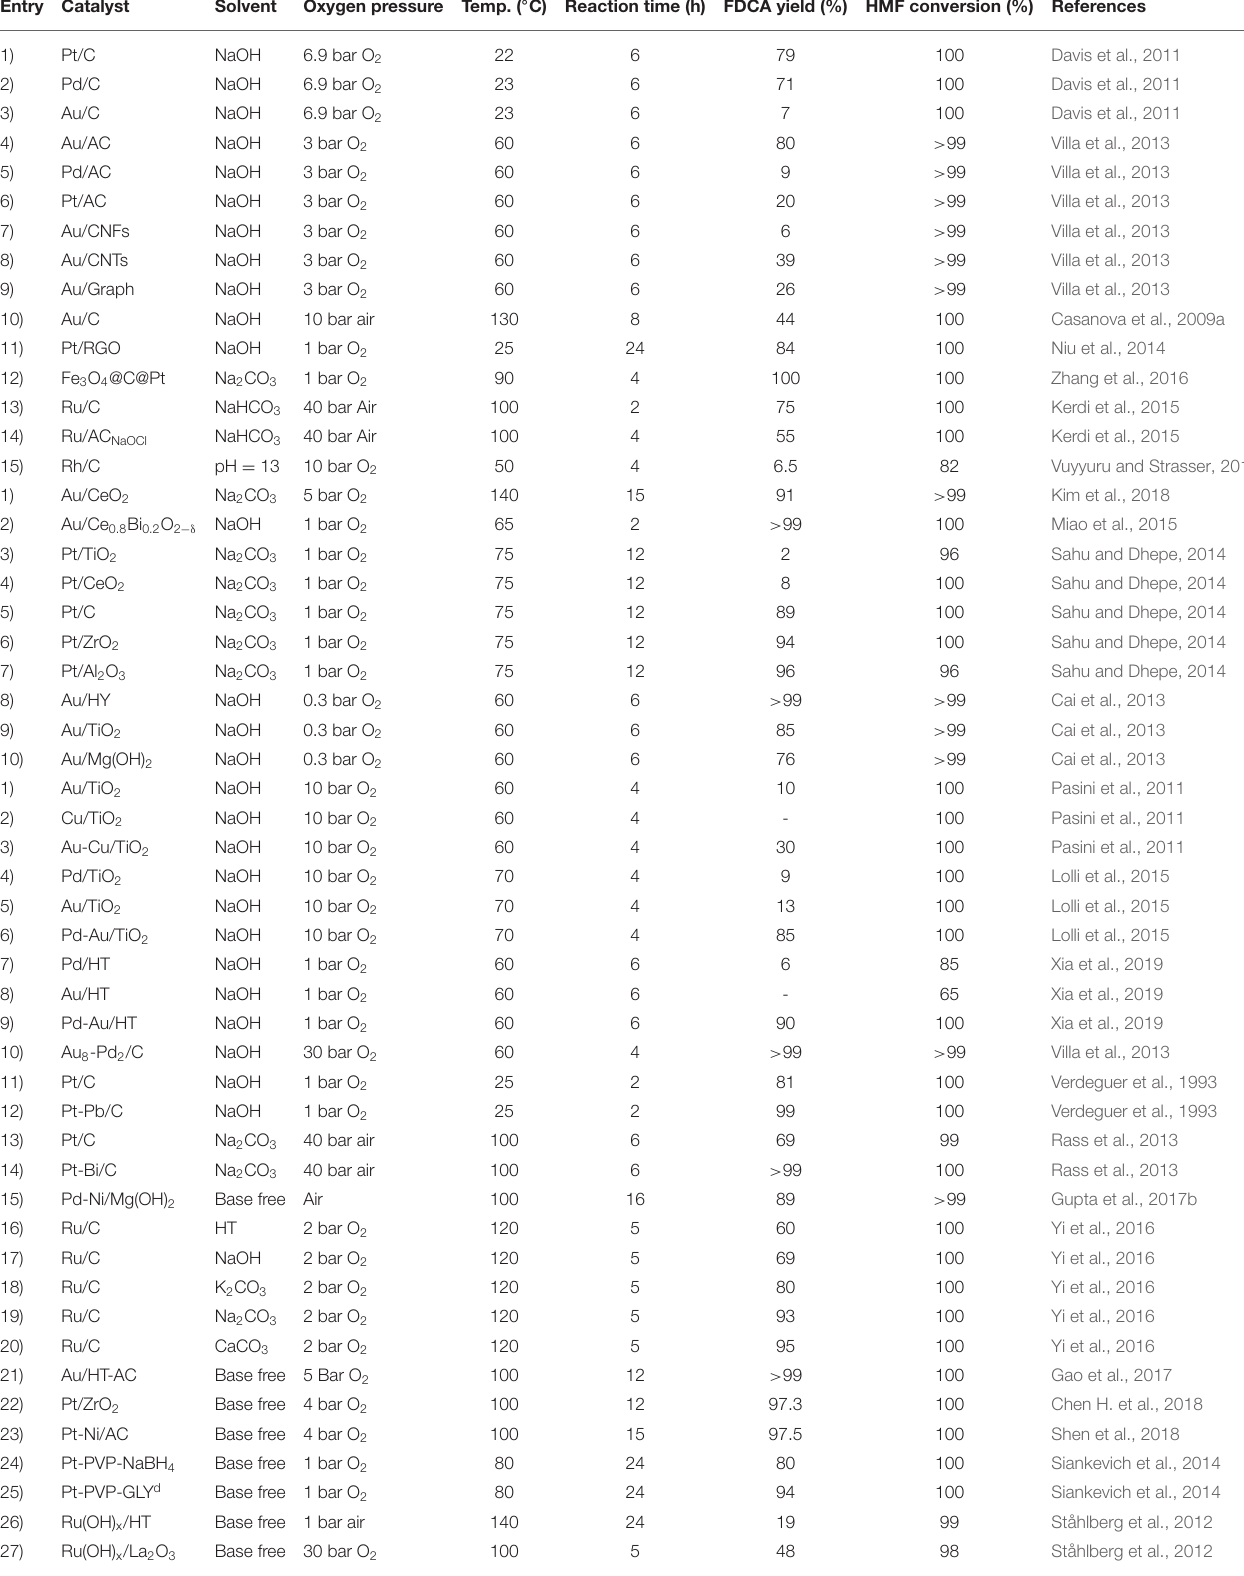
TABLE 2 | HMF oxidation processes to FDCA by using O 2 as the oxidant. Entry